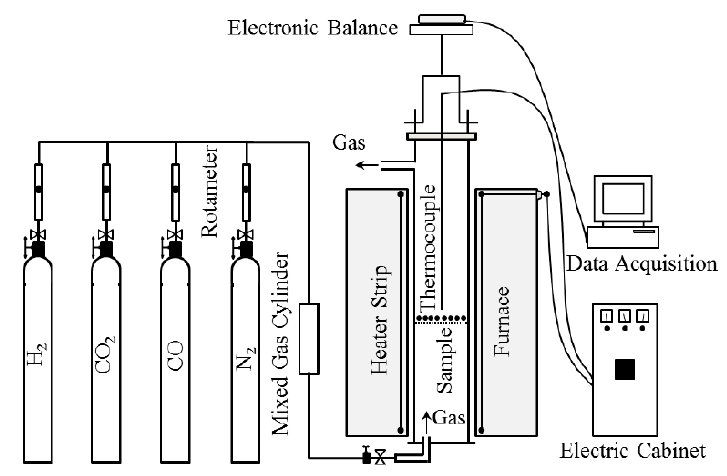
Figure 3. Schematic diagram of the experimental apparatus.